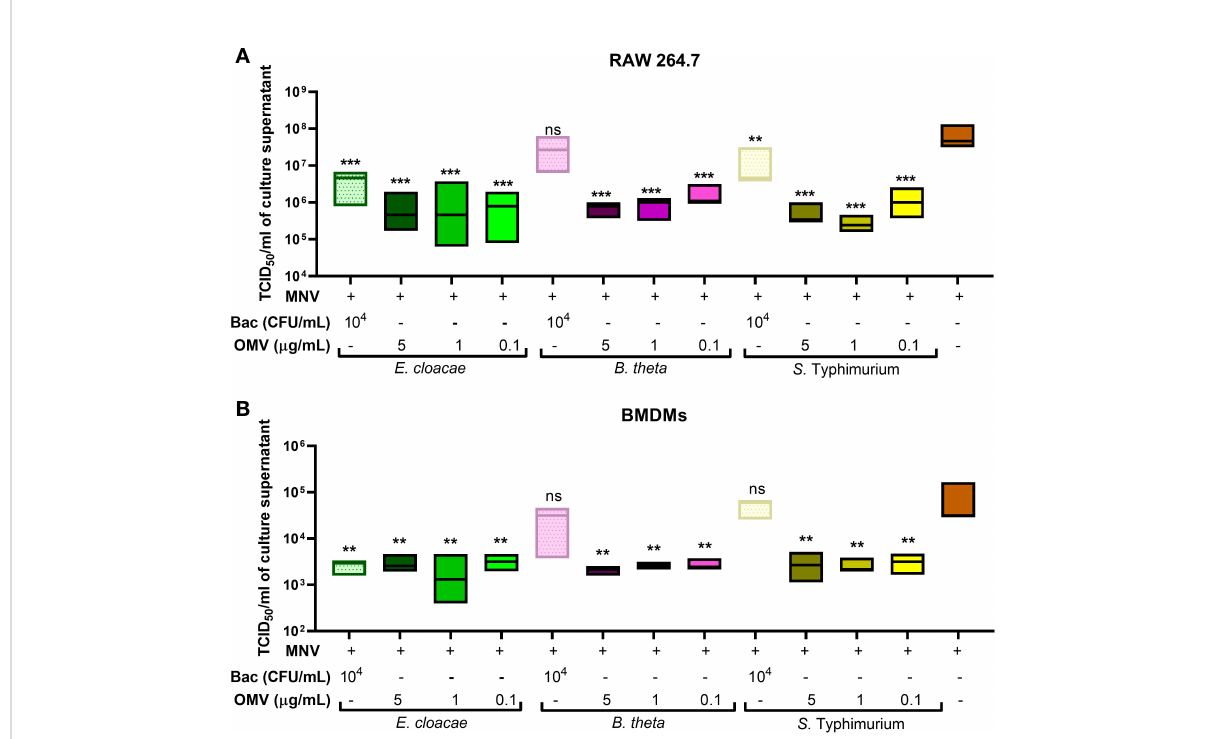
FIGURE 9 Quanti fi cation of MNV released after co-inoculation of macrophages. The supernatant was collected from (A) RAW264.7 cells and (B) BMDMs inoculated with MNV only or co-inoculated with MNV and heat inactivated bacteria (Bac) or their OMVs.TCID 50 assay was used to measure the MNV output titer for each treatment and compared to that of MNV-only infection. Ordinary one-way ANOVA was used to analyze changes in MNV titer. (n=3; ns= not signi fi cant, **=p<0.01,